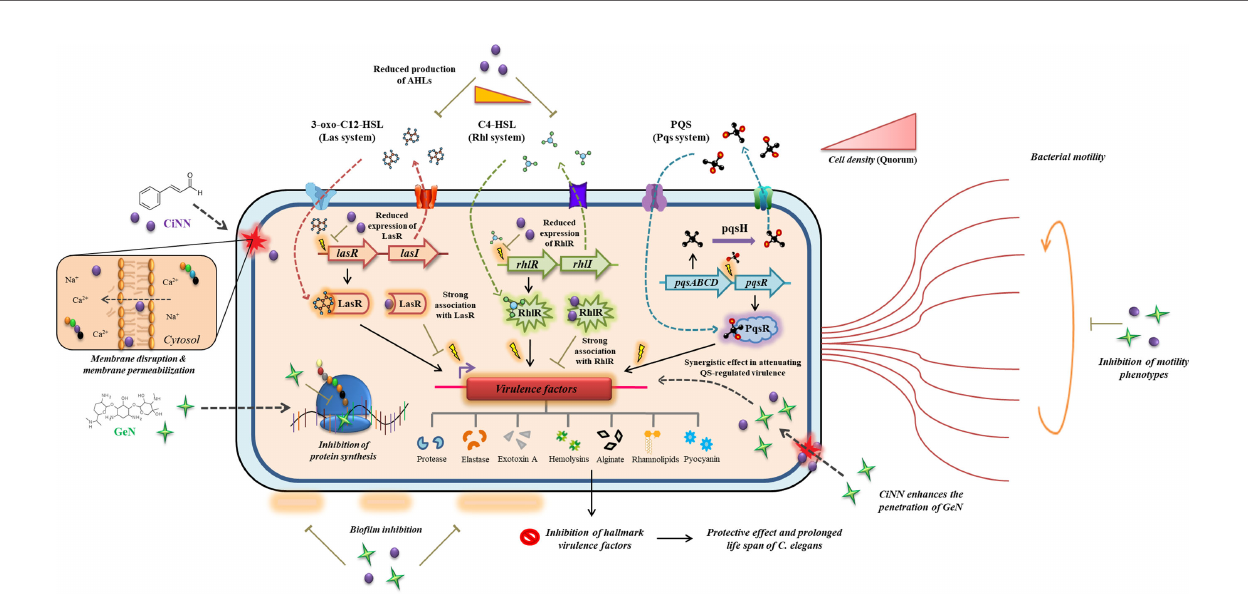
FIGURE 10 | Mechanistic model depicting the possibilities behind the synergistic interaction of CiNN-GeN and its outcomes in attenuating the QS circuits and QS- regulated virulence in P. aeruginosa . The distinct mode of action exhibited by CiNN and GeN have been illustrated alongside their combination